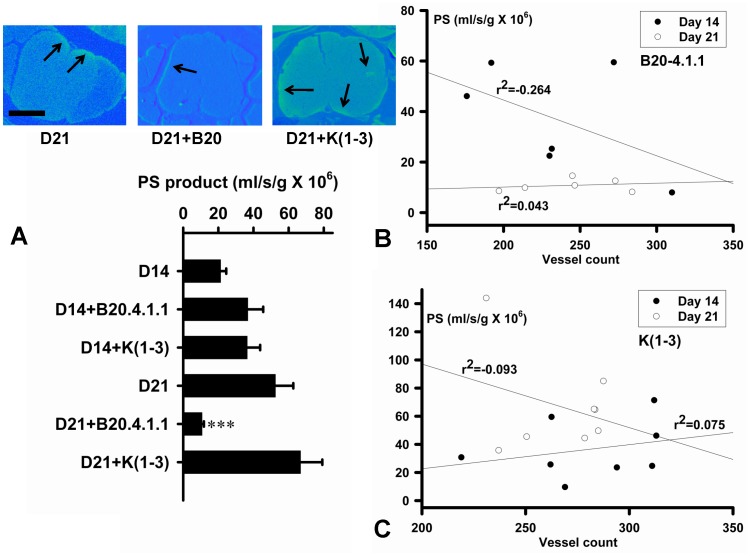
B20.4.1.1 but not K(1-3) Reduces Permeability-Surface Area Product (PS) Values During EAE.A. Upper panels show representative permeability maps for indicated treatment groups at day 21. Arrows indicate regions of increased PS within the spinal cord. Scale bar = 200 µm. Lower bar chart shows PS values at day 14 and 21 for EAE, EAE+B20.4.1.1 and EAE+K(1-3). PS values per mouse in each group (EAE only group: n = 6; B20.4.1.1 treated group, n = 6, K(1-3) treated group, n = 8); data are shown as mean ± SEM, significance compares EAE with each treatment (***; P<0.001). B, C. Regression plots for values from individual mice from day 14 (filled circles) and day 21 (open circles), comparing PS to vessel counts for mice treated with B20.4.1.1 (B) or K(1-3) (C). Regression lines through each data set are shown with the regression coefficient (r2).